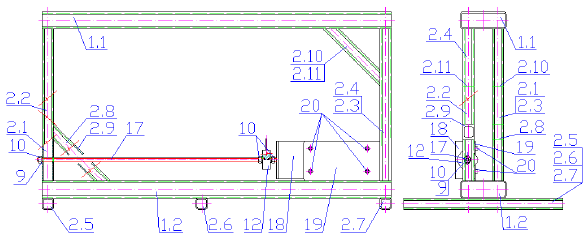
Figure 4: Testing equipment for the calibration of force transducers, 2D